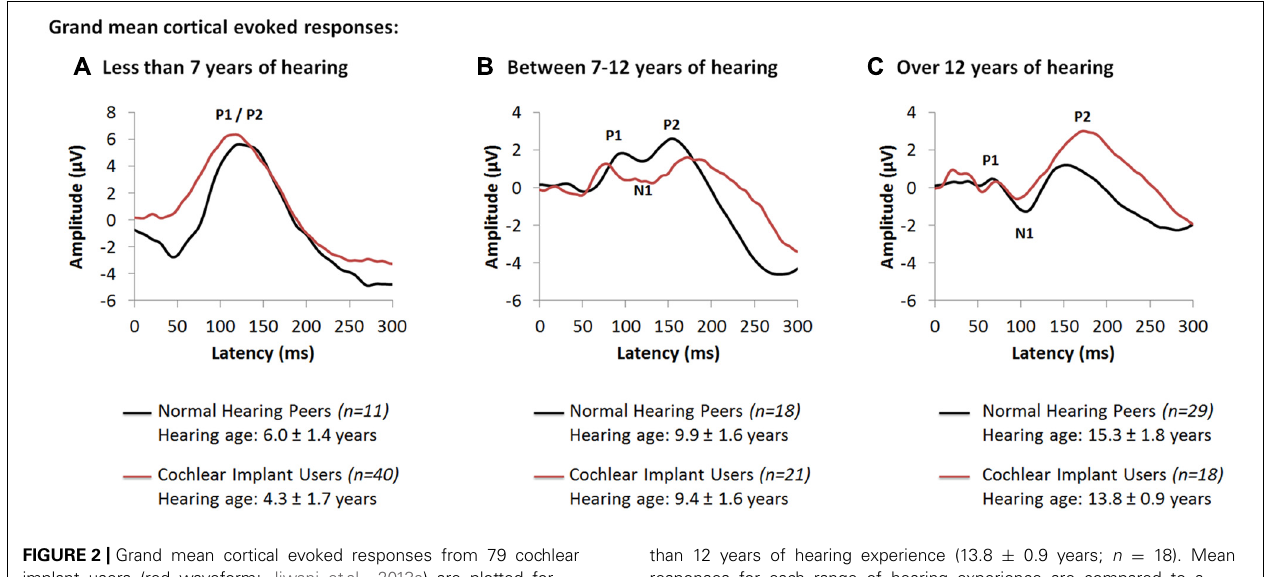
than 12 years of hearing experience (13.8 ± 0.9 years; n = 18). Mean responses for each range of hearing experience are compared to a normal and mature cortical waveform (black waveform; Jiwani etal., 2013a), recorded from normal hearing peers who are matched for hearing age ( n =